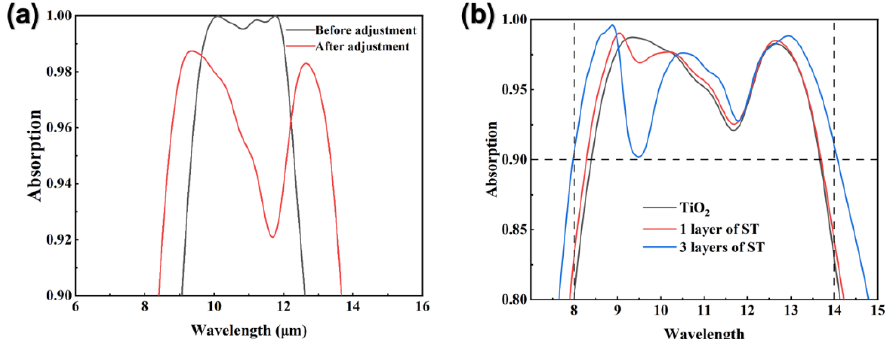
Figure 9. ( a ) Absorption spectra obtained by adjusting the surface structure. ( b ) Absorption spectra obtained by replacing the dielectric layer with ST (SiO 2 -TiO 2 film) layers.